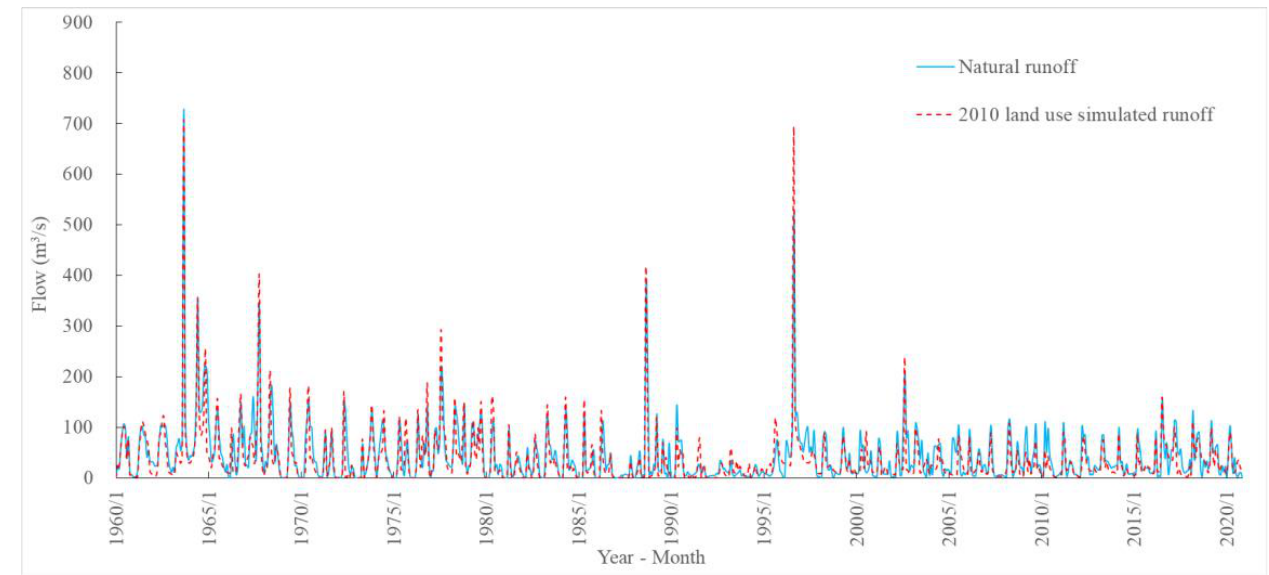
Figure 5. Comparison of simulated and natural runoff under the land-use scenario of 2000 at the Huangbizhuang Station.